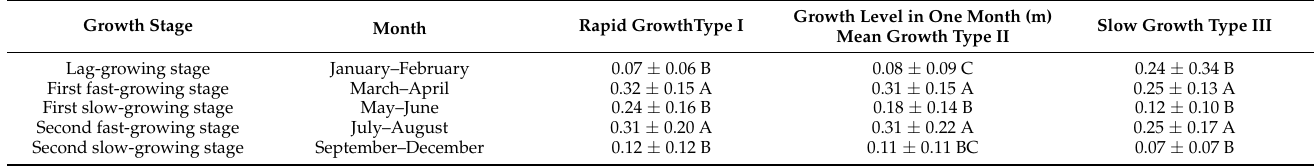
Table 7. Growth stage divisions of crown width in rows for three types of C. axillaris